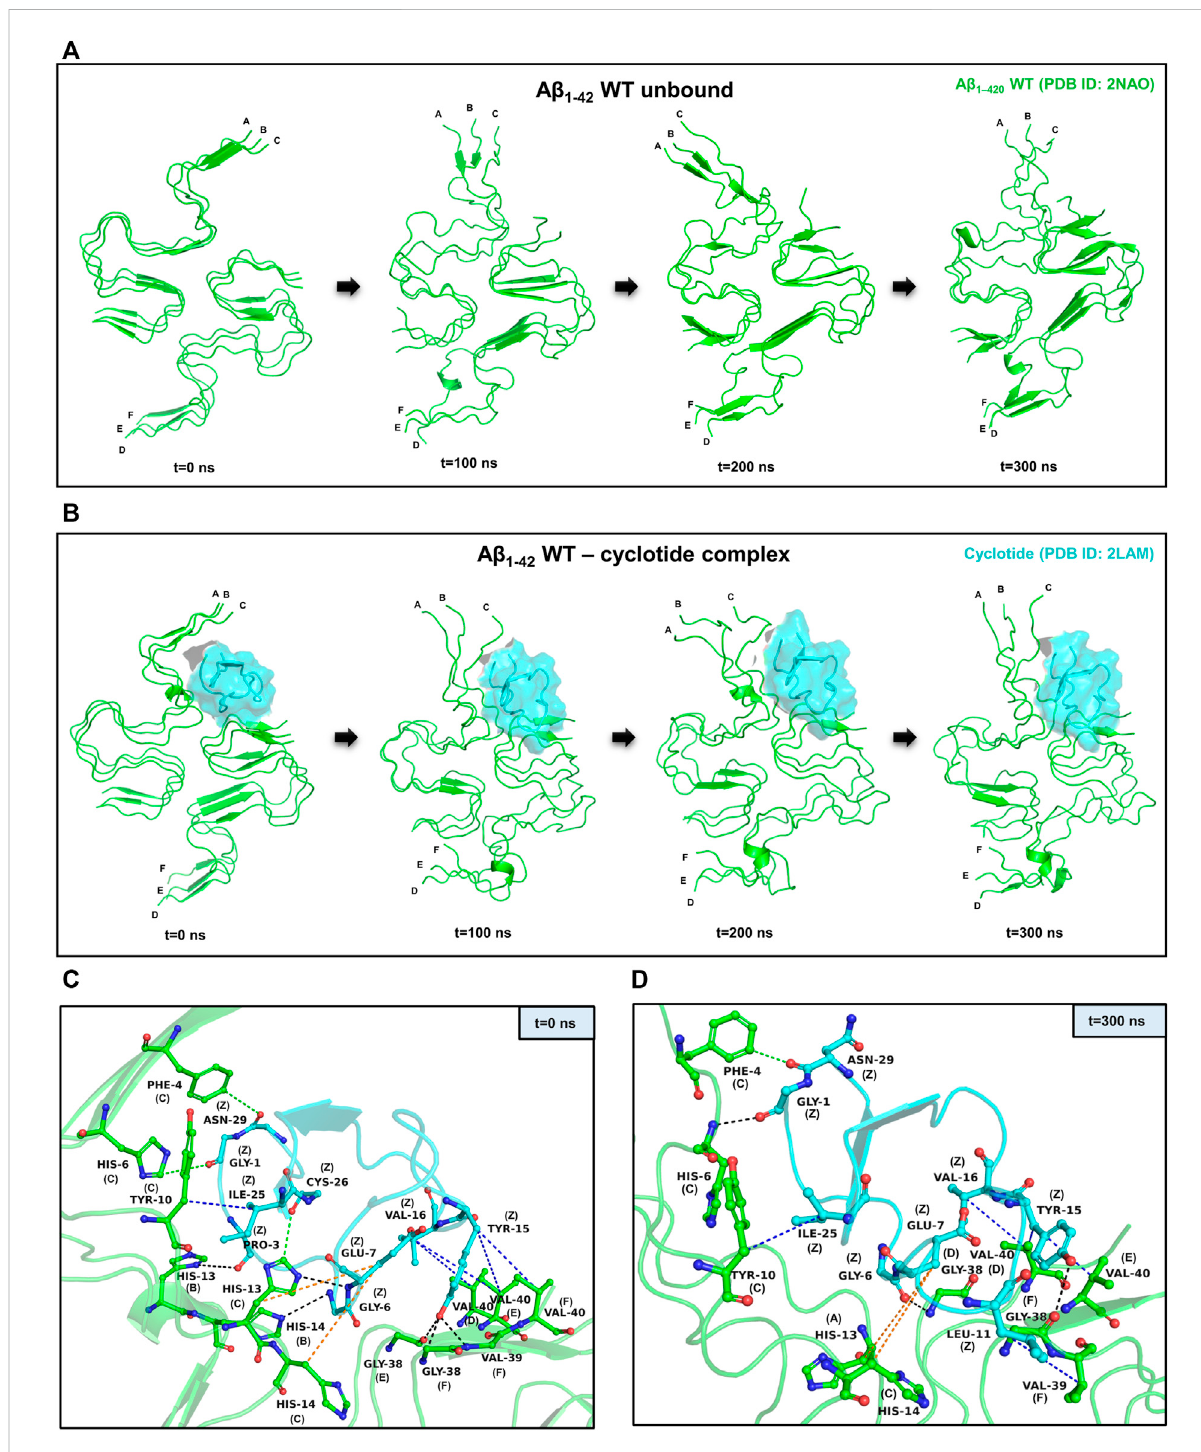
FIGURE 2 Representative example of MD simulations between the wild-type A β 1-42 fi bril and cyclotide Cter-M. (A) Snapshots of MD simulation of unbound A β 1-42 fi bril (PDB ID: 2NAO; green coloured cartoon representation) at different time points along the simulation period. (B) Snapshots of MD simulation of WT A β 1-42 fi bril (PDB ID: 2NAO; green coloured cartoon representation) and Cter-M (PDB ID: 2LAM; cyan surface representation) complexatdifferenttimepointsalongthesimulationperiod.Capitalletters,whichdenotethepolypeptidechainsof2NAO,areplacedatthe1st residue of each chain. (C,D) Molecular interactions between the WT A β 1-42 fi bril (PDB ID: 2NAO; chains A-F; green cartoon representation) and cyclotide Cter-M (PDB ID: 2LAM; chain Z; cyan cartoon representation) at the beginning (0 th ns snapshot) and end (300 th ns snapshot) of the simulation period, respectively. Colour scheme for interactions used: classical hydrogen bonds in black, aromatic hydrogen bonds in green, hydrophobic interactions in blue and electrostatic interactions in